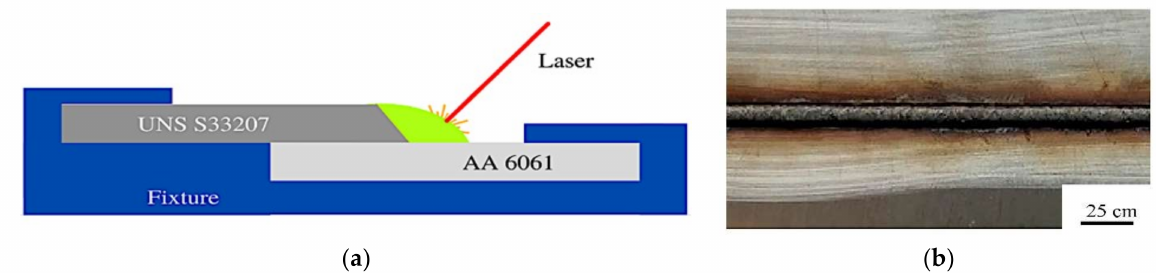
Figure 1. ( a ) Laser welding setup; ( b ) Laser welding plate using HEAs